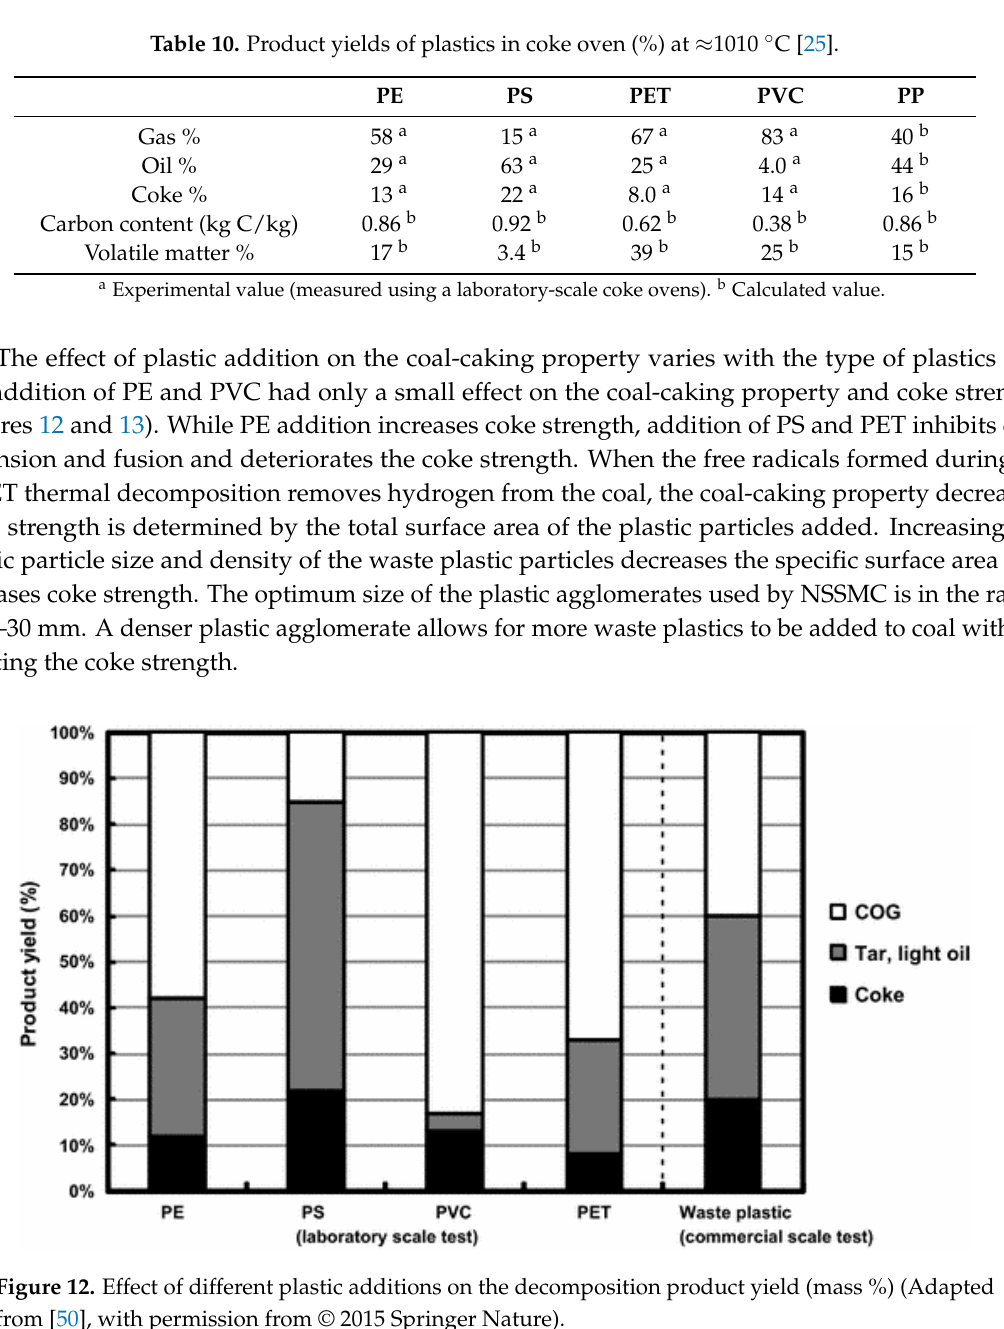
Figure 13. Effect of adding various plastics (2% mass) on coke strength 𝐷𝐼 (cid:2869)(cid:2873)(cid:2869)(cid:2873)(cid:2868) (Adapted from [50], with permission from © 2015 Springer Nature). Coke is produced in a coke oven by carbonizing, i.e., heat treating the coal without oxygen at a high temperature. Coke can be produced via the chemical feedstock recycling of waste plastics in the coke oven [50]. When agglomerated waste plastics blended with coal at the blending ratio of about 1 wt. % are charged into the coke oven they are converted into coke, COG and hydrocarbon oil like coal in the coking chamber. In this process, carbon and hydrogen contained in the waste plastics are converted to 20 wt. % coke, 40 wt. % hydrocarbon oil (tar and light oil) and 40 wt. % coke oven gas